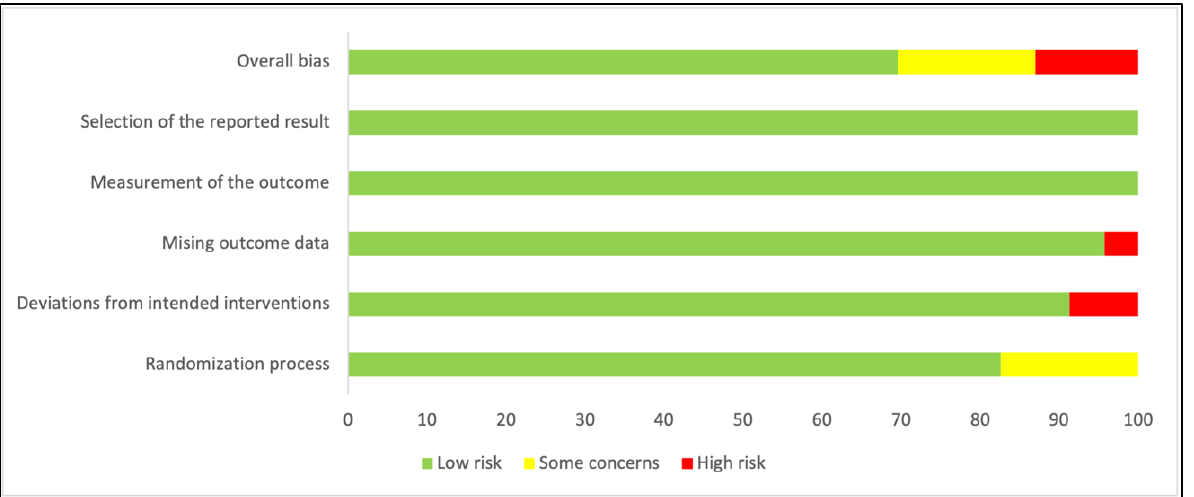
Figure 3. Risk of bias for weight-for-age in LMIC. The figure shows the five domains of the risk of bias 2.0 tool and the overall bias. The horizontal axis depicts percentage of studies. Most of the studies were at low risk of bias.